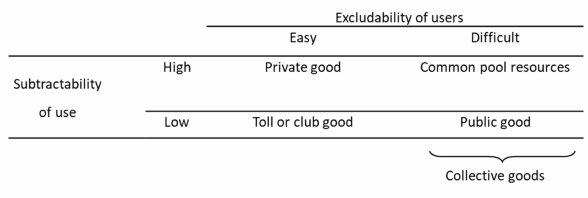
Fig. 1 . Typology of goods and services adapted from Ostrom (2005), including definition from Hinkel et al.